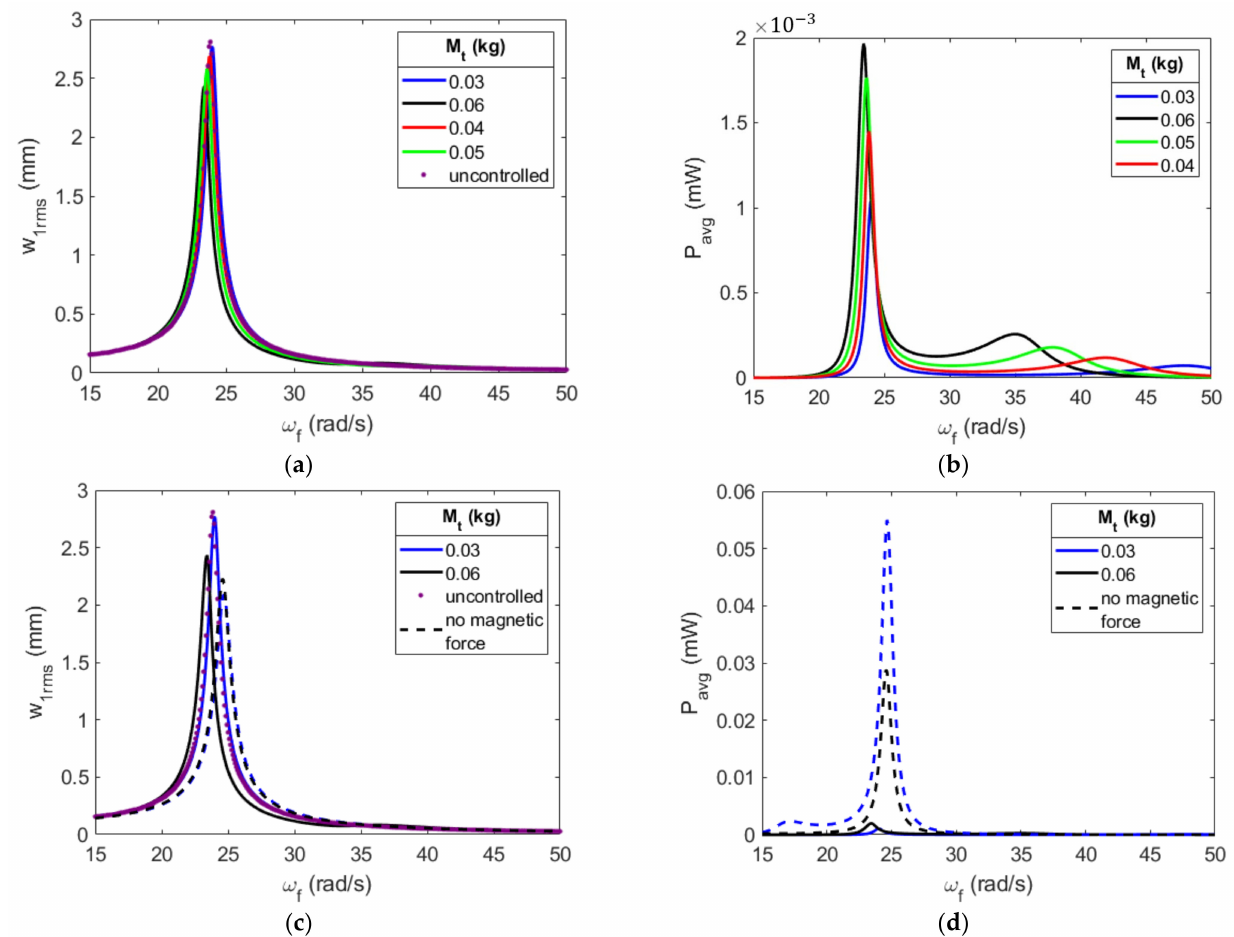
Figure 20. The effects of varying tip masses with a substrate thickness of 0.3 mm and an initial gap of 5 mm on the amplitude of the ( a ) primary structure and ( b ) absorber, as well as a comparison with configurations with no magnets ( c , d ).